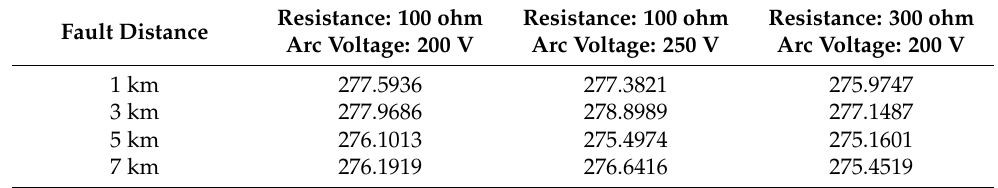
Table 2. Results of our time-domain detection method obtained under different fault conditions.